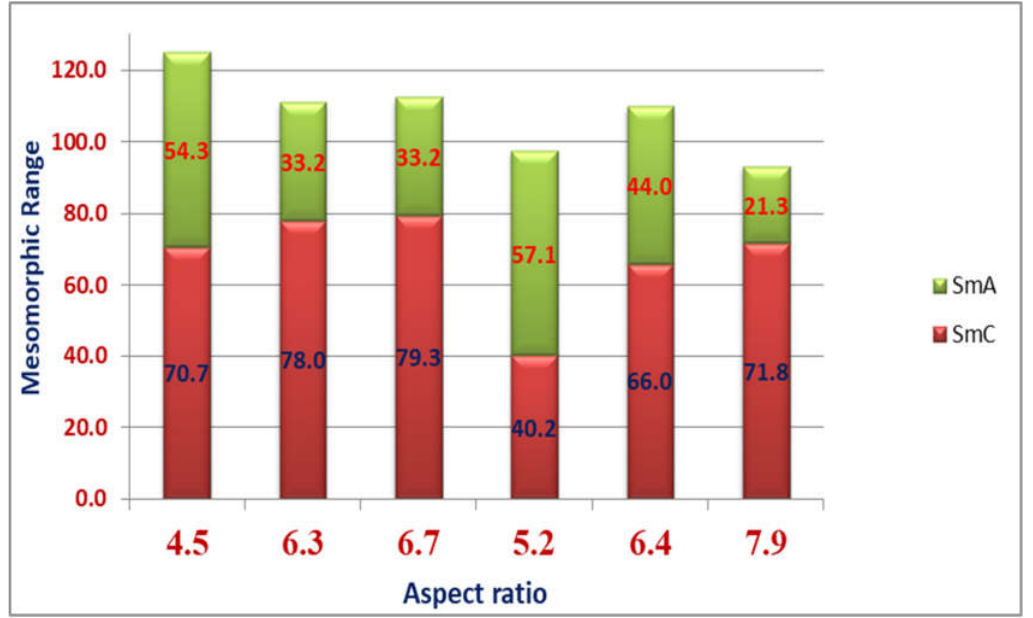
Figure 7. Dependence of the aspect ratio of the prepared compounds with the mesomorphic range.